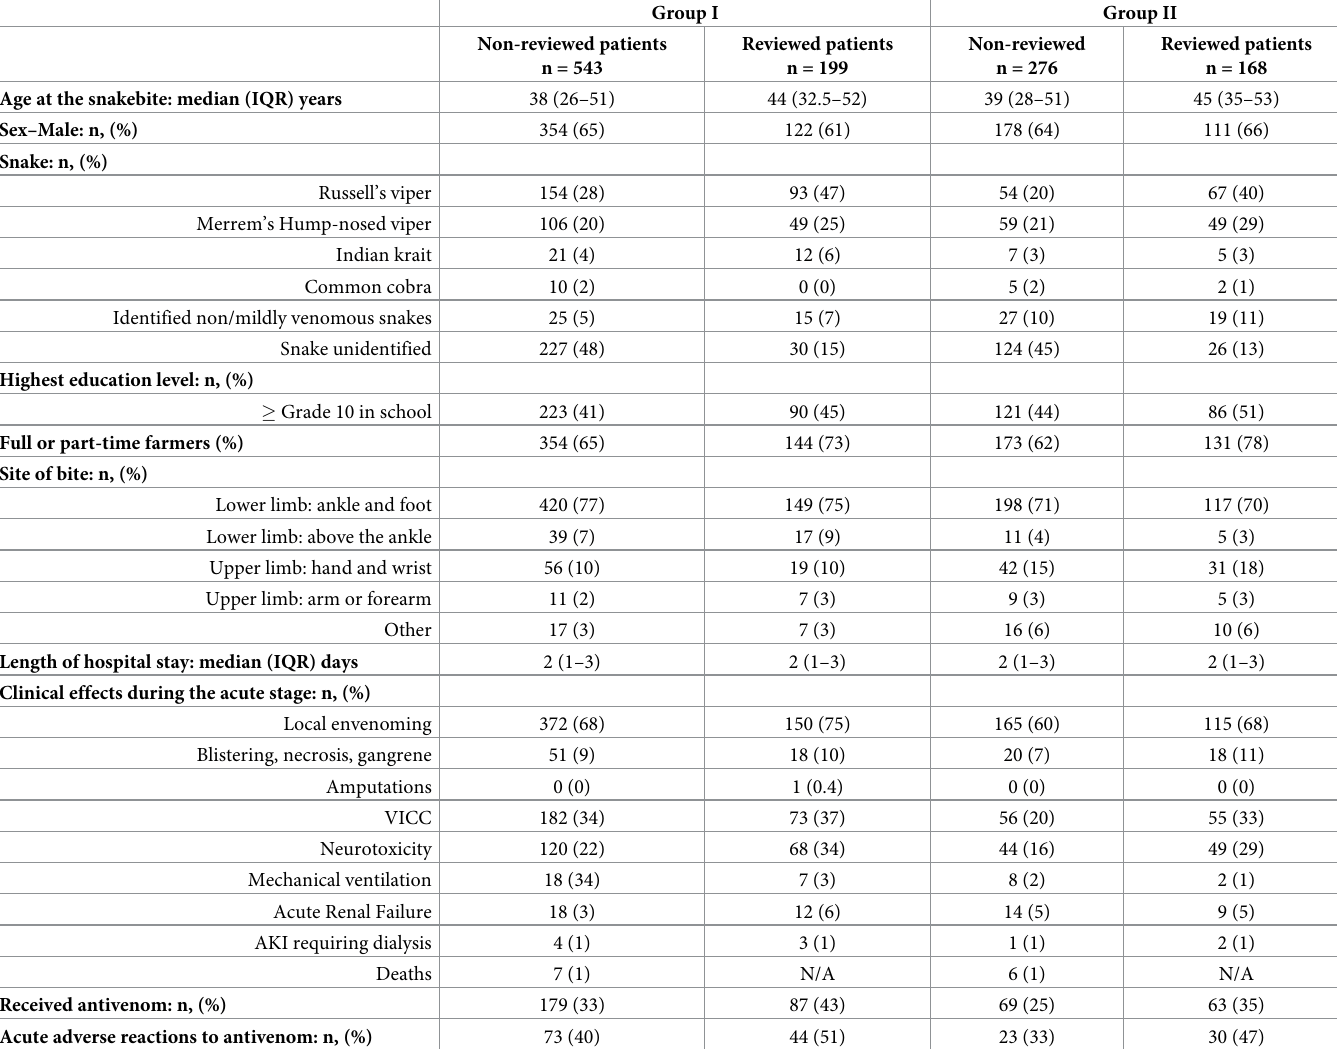
Table 1. The demographic characteristics of all patients and the reviewed patients of group I and group II of the Anuradhapura Snakebite